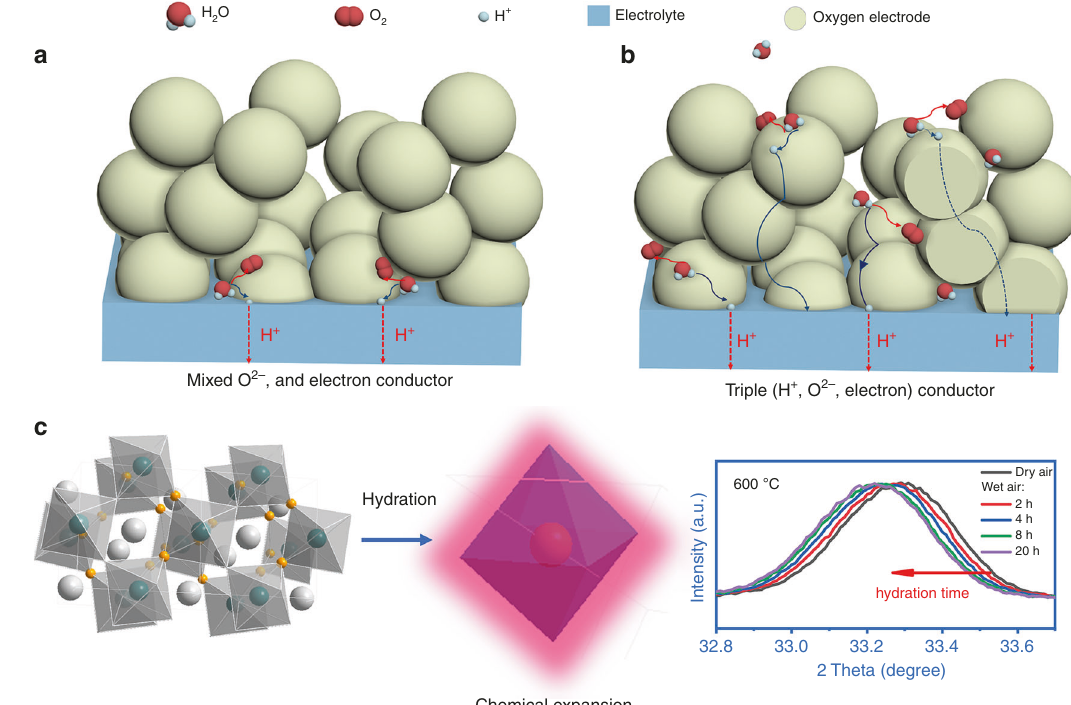
Fig. 1 Water splitting reaction on oxygen electrode and PNC ’ s hydration. a Mixed oxygen-ion O 2 − and electron conducting electrode. b Triple (H + , O 2 − , and electron) conducting electrode to extend reaction to entire electrode surface. c Chemical expansion of PNC perovskite structure observed in high- temperature X-ray diffraction at 600 °C when exposed to wet